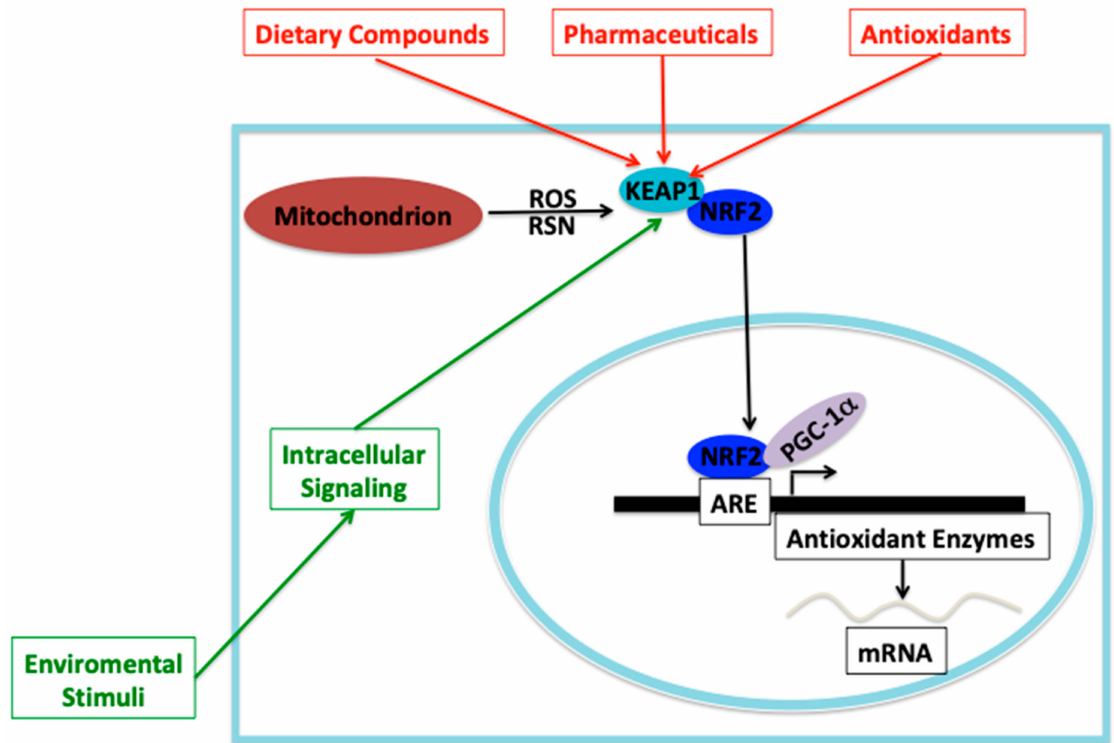
Figure 3. Signaling pathways and mitochondrial biogenesis. There are multiple signaling pathways that could lead to mitochondrial biogenesis. The main cellular energy sensor is the AMPK, which is able to sense the low energy status and transduces the signal by phosphorylating SIRT1, which in turn can deacetylase PGC-1 α to activate it to perform transcriptional coactivation on the NRF transcriptional (NRF1 and NRF2) activators to stimulate gene expression of mito- chondrial genes to start mitochondrial biogenesis. Furthermore, AMPK can directly activate PGC-1 α via phosphorylation. Additionally, certain stimuli can elicit calcium signaling to activate CaMK, which activates p38MAPK to phosphorylate PGC-1 α to activate its transcriptional coactivator function and launch mitochondrial biogenesis. Environmental stimuli can directly activate CaMK, which can signal p38MAPK to phosphorylate PGC-1 α and activate it. On the other hand, environmental stimuli or cAMP can activate PKC, which is able to phosphorylate CREB, which in turn can bind to the CRE on the gene promoter of PGC-1 α gene to augment its expression, which can be activated by the mentioned signals to begin the mitochondrial biogenesis process. All signals can augment the gene expression of nuclear-encoded mitochondrial proteins involved in OXPHOS function, Tfam mitochondrial transcription factor and mitochondrial structural